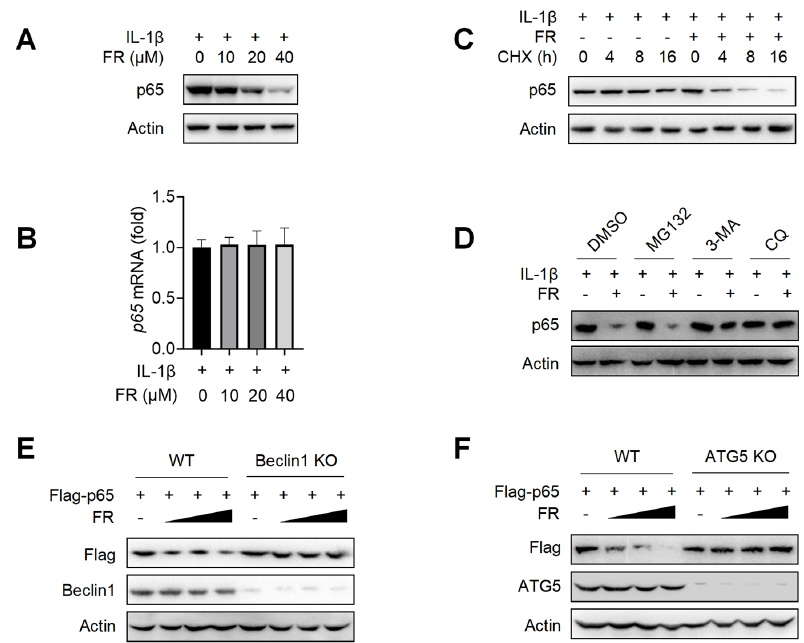
Figure 4. FR degrades p65 through an autophagy-lysosome pathway. Tenocytes were treated with IL-1 β (10 ng/mL) and FR (40 µ M) for 24 h. ( A ) The expression of p65 protein was detected by WB. ( B ) The mRNA expression of p65 was detected by qRT-PCR. ( C ) Tenocytes were treated with